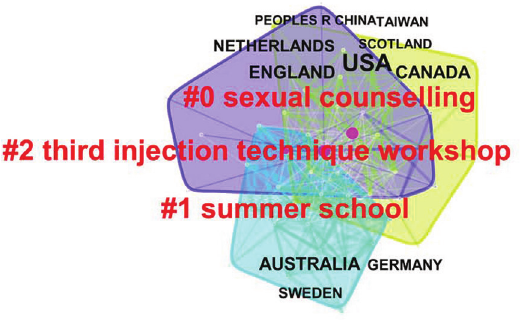
Figure 3. Knowledge map of country related to Nurse Practitioners